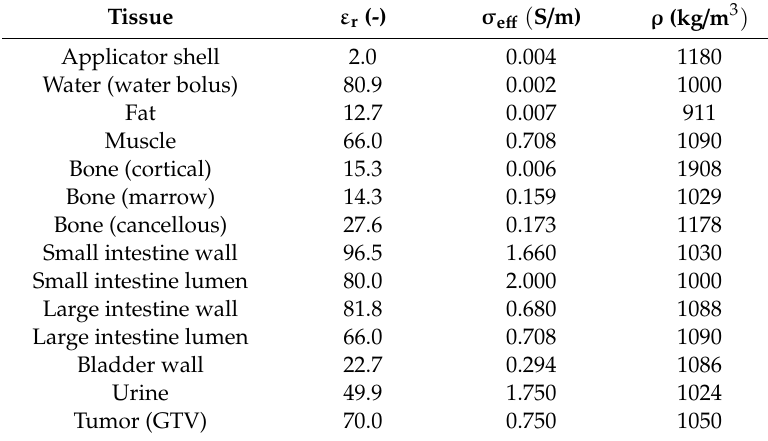
Table 2. Relative permittivity ( ε r ), e ff ective conductivity ( σ e ff ) , and mass density ρ for the selected tissues at 100